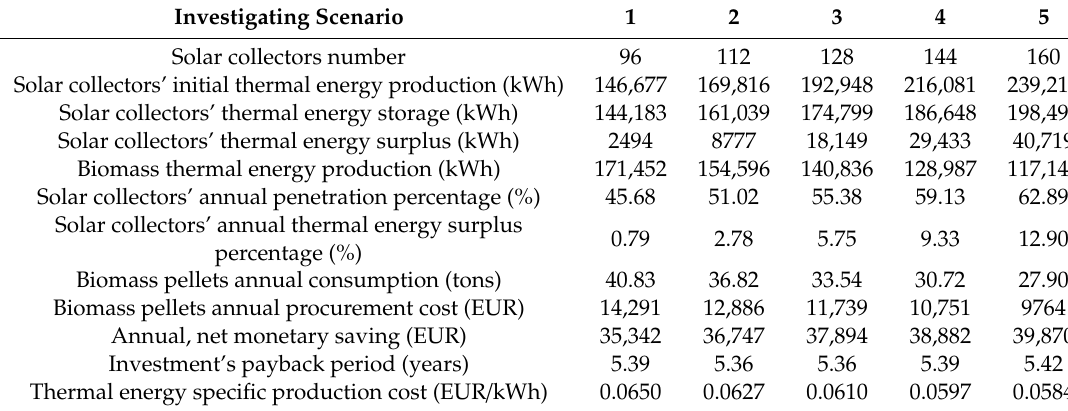
Table 7. Results of the iterative dimensioning